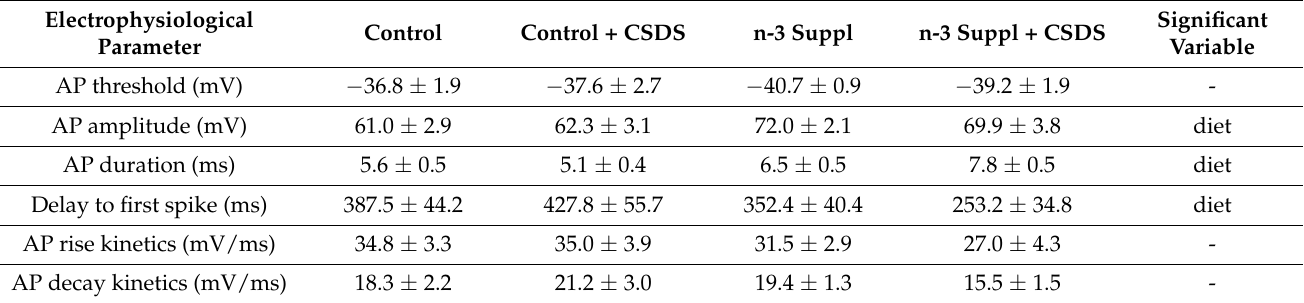
Table 1. Electrophysiological spike properties in medium spiny neurons of control and n-3- supplemented (n-3 suppl) mice. Values are rounded to 1 decimal point and are represented as the mean ± SEM. AP: action potential, CSDS: chronic social defeat stress, SEM: standard error of the mean. Refer to Supplemental Table S1 for additional details of the two-way